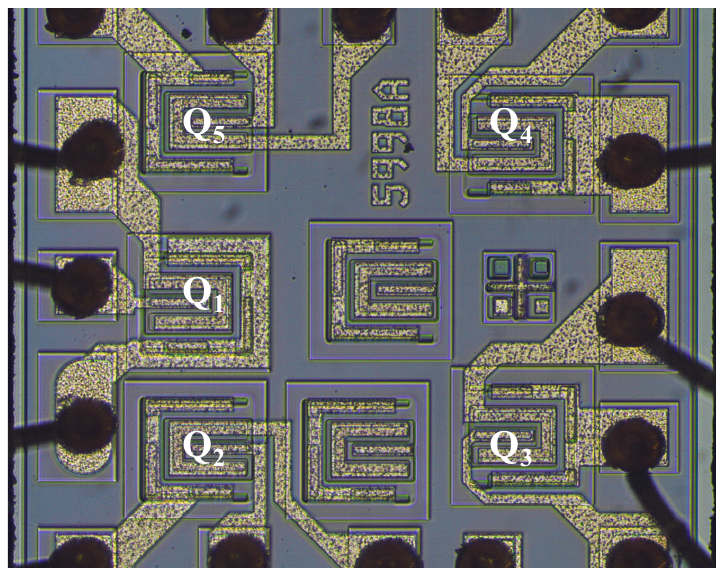
Figure 8. Front side view of the